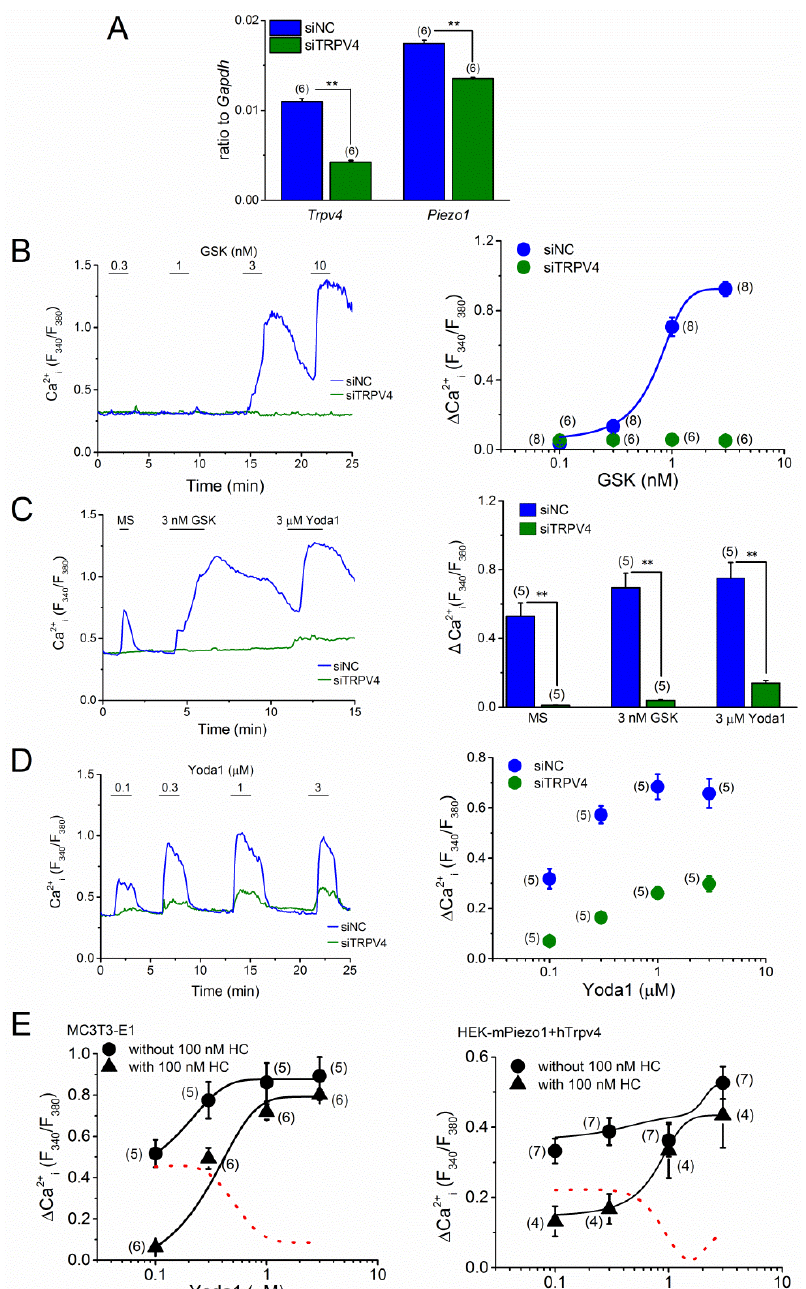
Figure 6. TRPV4-knockdown in the MC3T3-E1 cells and its e ff ect on GSK- and MS-induced Ca 2 + response. The expression of TRPV4 in MC3T3-E1 cells was reduced by siTRPV4 treatment for 96 h. ( A ) The mRNA expression level of Trpv4 and Piezo1 in MC3T3-E1 cells transfected with siTRPV4 compared to the cells transfected with stealth control siRNA (siNC). ( B ) A representative Ca 2 + response to GSK at a concentration ranging from 0.3 to 10 nM (left panel) and the concentration-response relationship of GSK-induced peak change in Ca 2 + response in the cells treated with either siTRPV4 or siNC (right panel). ( C ) The e ff ect of TRPV4 knockdown on MS-induced Ca 2 + response. A representative Ca 2 + response to MS (7.67 µ L / s), GSK (3 nM), and Yoda1 (3 µ M) in MC3T3-E1 cells treated with either siTRPV4 or siNC was shown (left panel) and pooled data were summarized (right panel). ( D ) Concentration-response relationship of Yoda1-induced peak Ca 2 + response in the cells treated with either siTRPV4 or siNC. A representative Ca 2 + response change against time (left panel) and summary (right panel) was exhibited. ( E ) The effect of HC on Yoda1-induced response in MC3T3-E1 cells (left panel) and HEK cells expressing both PIEZO1 and